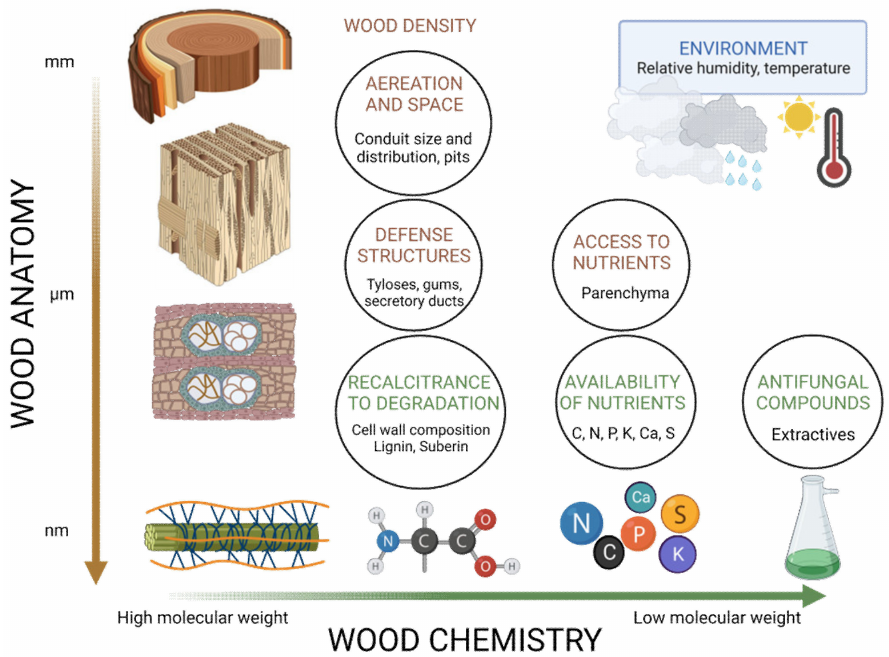
Figure 7. Anatomical, chemical and environmental factors involved in natural durability of wood. According to the vertical axis, factors vary from macroscopic to microscopic and molecular scales. Created with